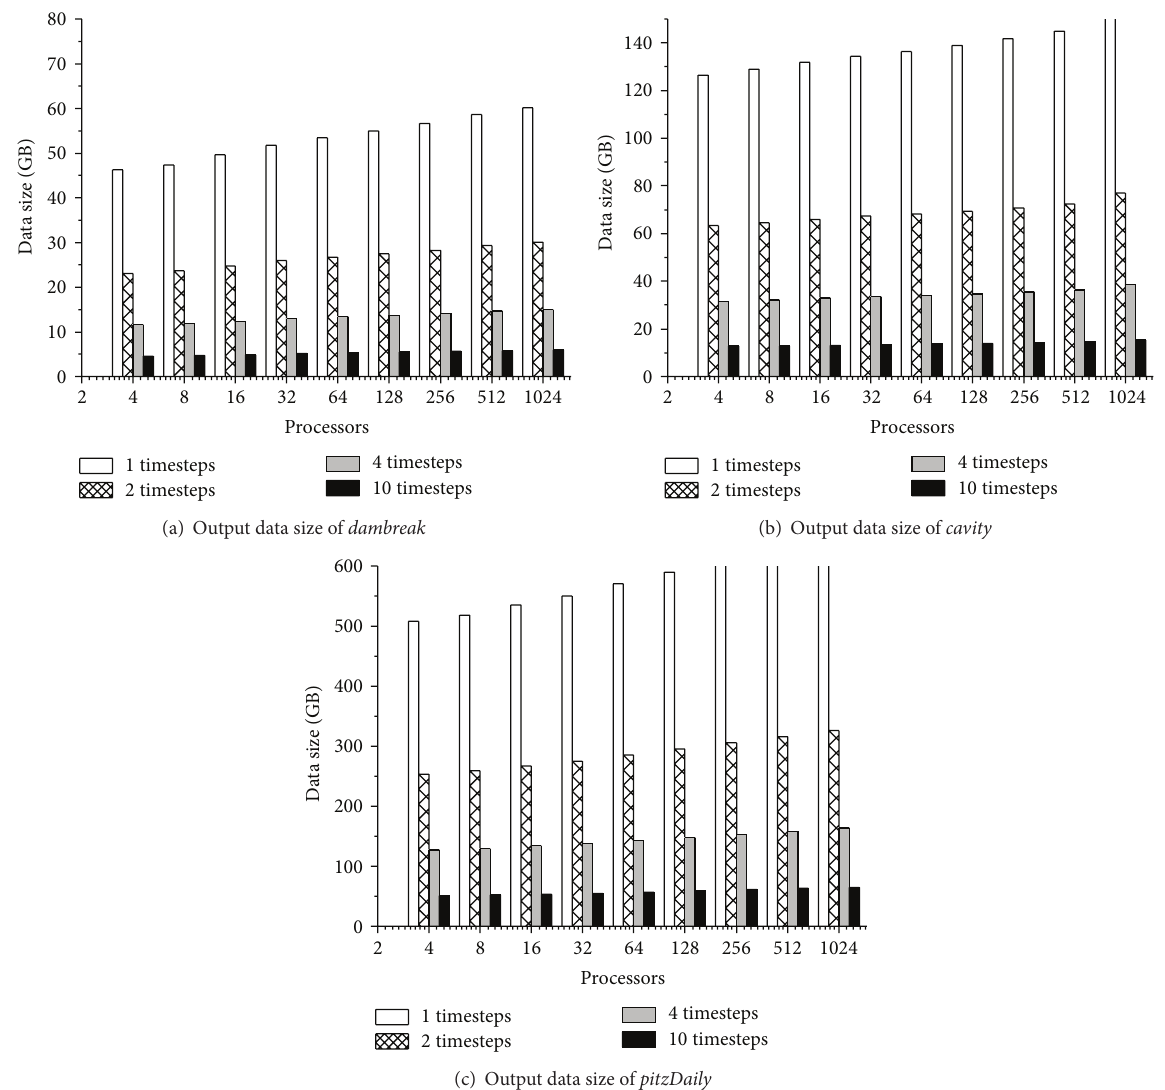
Figure 9: CFD application file output volume increases with scale of the number of